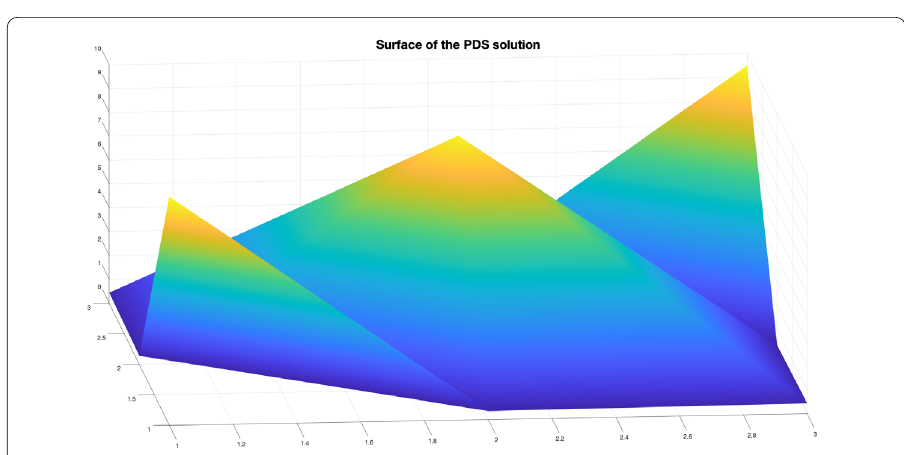
Figure 2 Solution surface